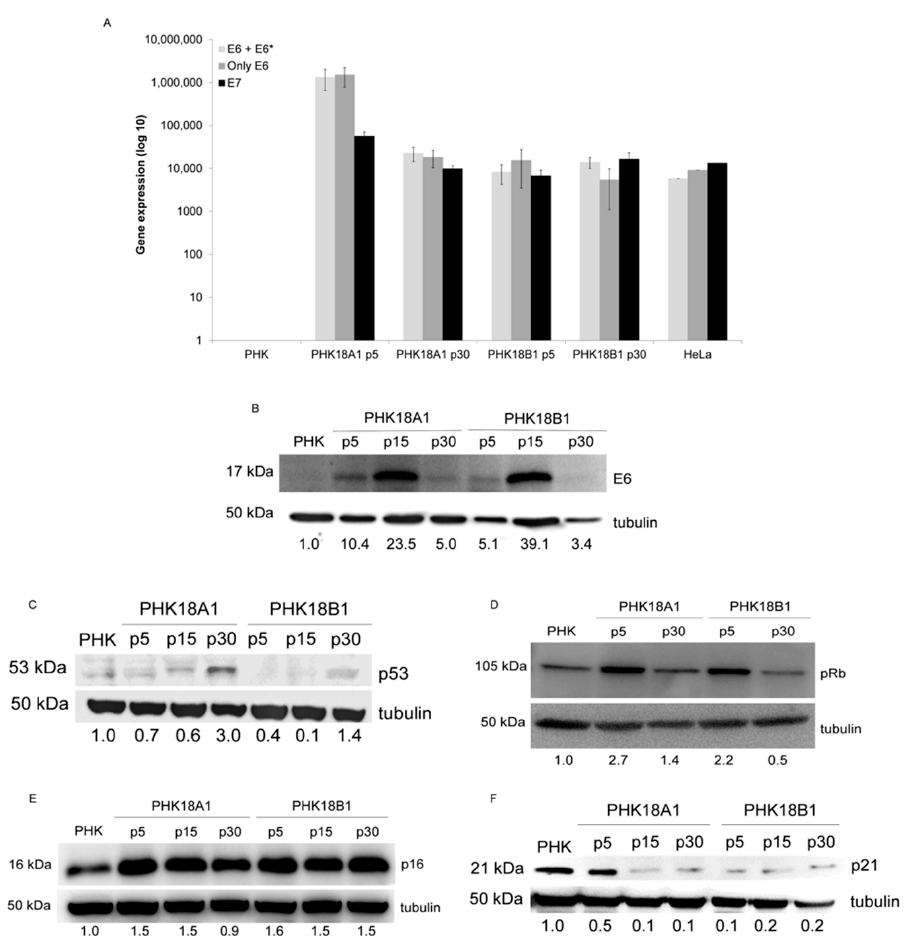
Figure 2. E6, E6*I, E7, p53, p16, pRb, and p21 levels in PHK18A1 and PHK18B1: ( A ) qRT-PCR to quantify E6 + E6*I, E6 alone, and E7 expression. Mitochondrial ribosomal RNA S18 gene expression was used for normalization. Means and standard errors of three independent assays performed in triplicate is presented; ( B ) E6 protein levels. A total of 120 µ g of protein extracts were fractionated in SDS–PAGE and the levels of E6 were analyzed by Western blotting; ( C ) p53, ( D ) pRb, ( E ) p16, and ( F ) p21 protein levels. A total of 80 µ g of protein extracts were fractionated in SDS–PAGE and protein levels were analyzed by Western blotting. For ( B – F ), tubulin levels were used as loading control. Representative experiments of two assays are presented.